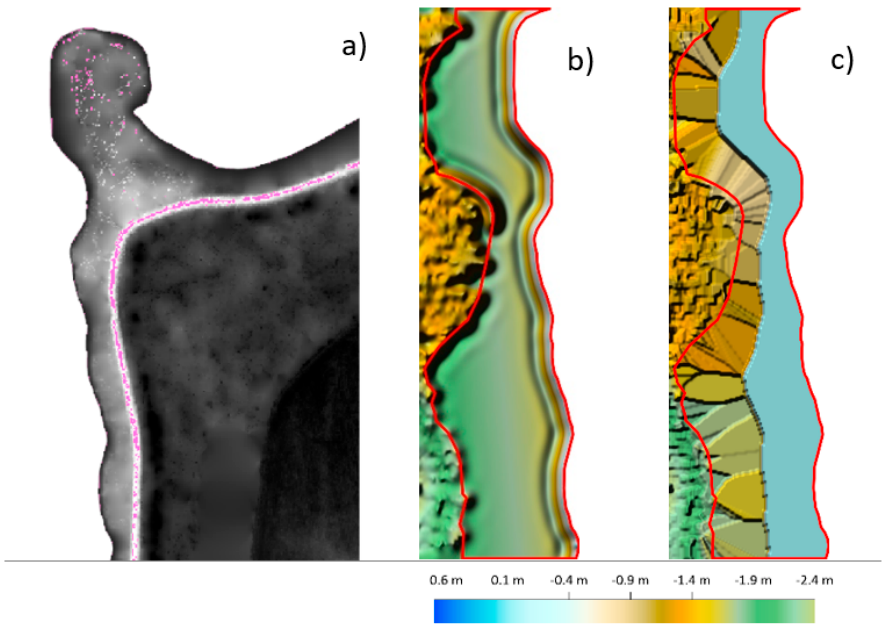
Figure 8. Cases of inappropriate surface modeling for: ( a ) missing data in the surface under the natural neighborhood method (marked in pink), ( b ) artifacts in the area missing bathymetric data under the minimum curvature method, ( c ) artifacts under the nearest neighbor method.